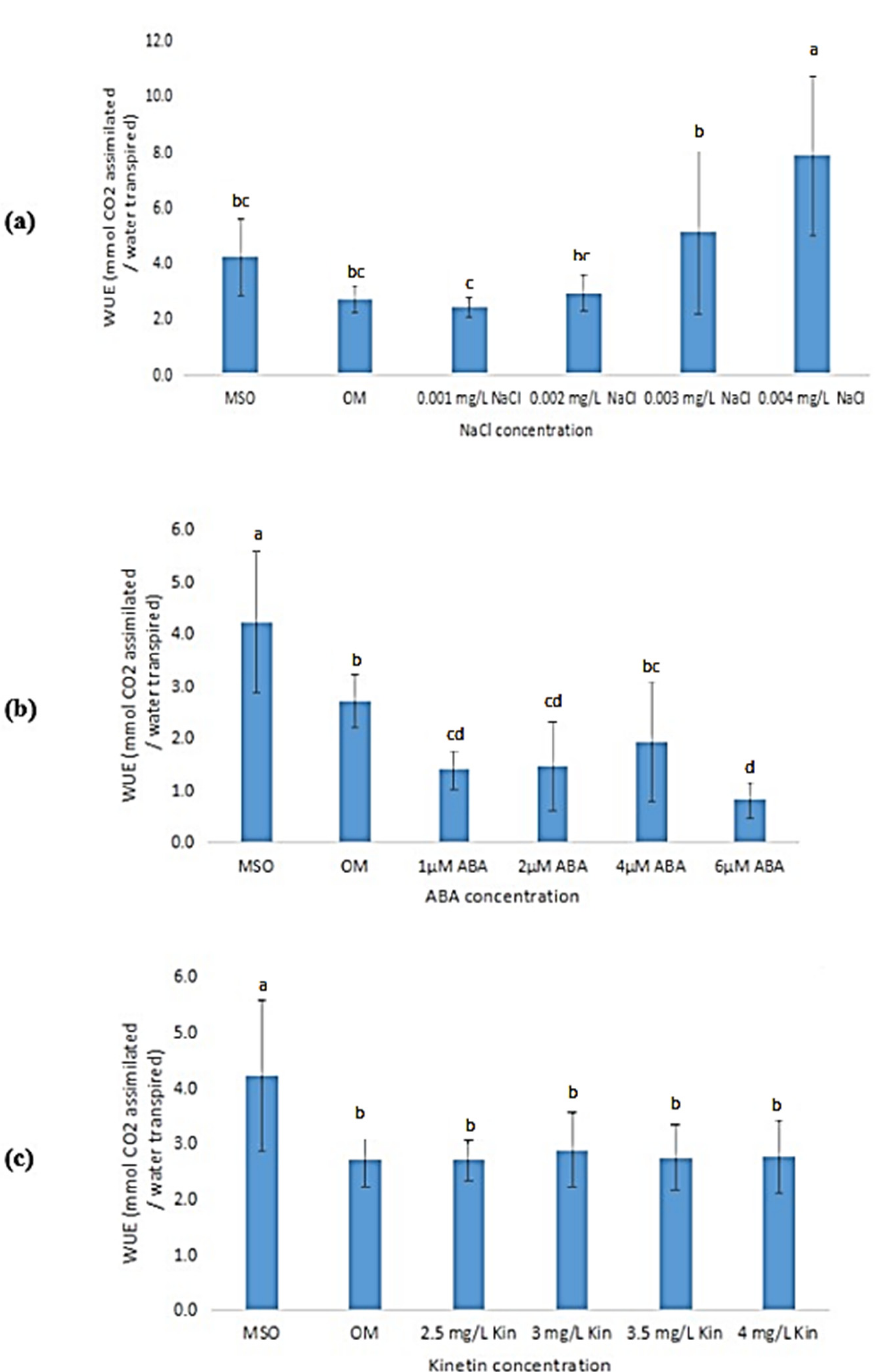
Figure 13. Water use efficiency (WUE) of plants exposed to: ( a ) salt stress; ( b ) ABA; ( c ) high kinetin levels. Means with different letters are significantly different at p < 0.05 according to Duncan’s multiple range test (DMRT).